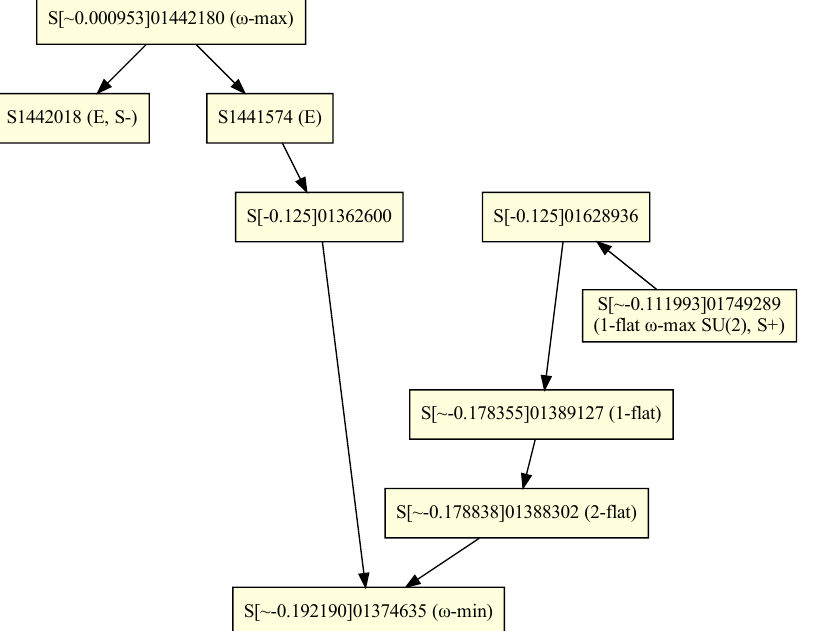
Figure 3. Schematic structure of the S1442018-equilibrium’s ω -deformation trajectory. Arrows point in the direction of decreasing ω . ‘E’=‘Non-Dyonic gauging’, ‘S-’=‘Trajectory continues symmetrically under a sign change of dω/ds ’, ‘S+’=‘Trajectory continues symmetrically around this ω -extremum’.